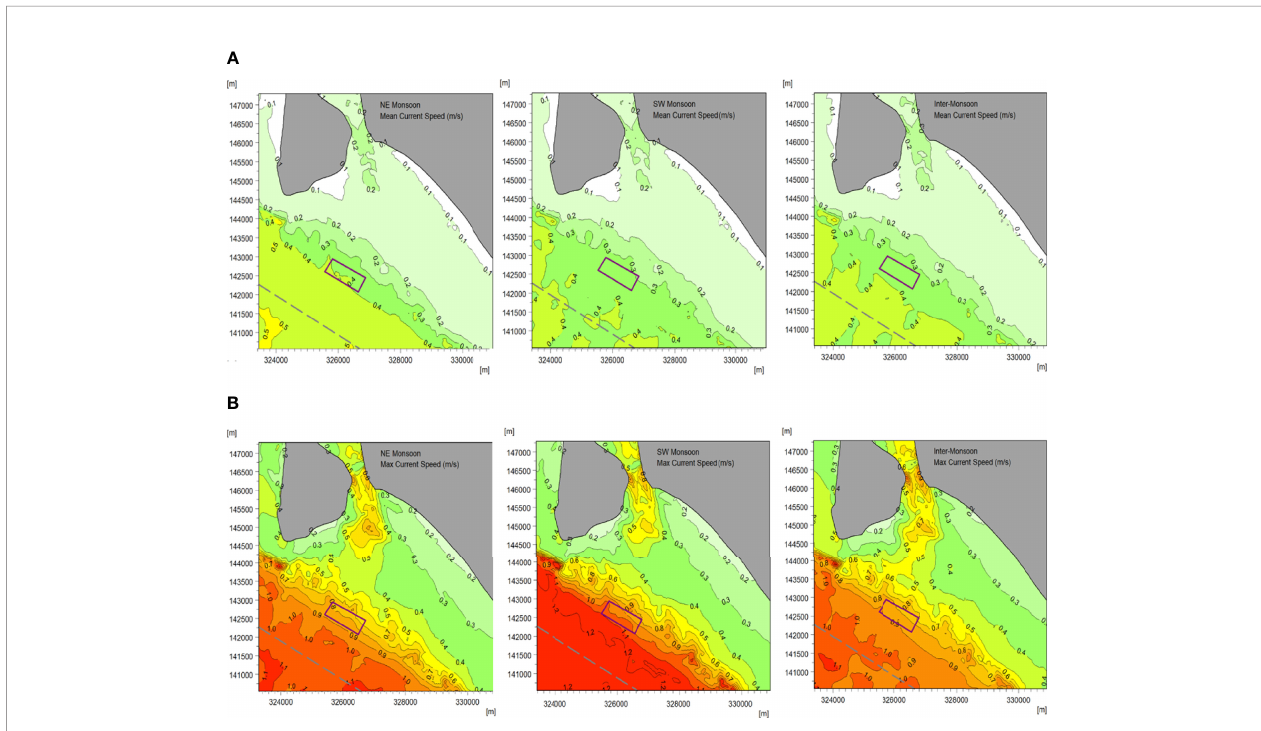
FIGURE 4 | Mean (A) and maximum (B) current speeds calculated from 28-day simulation results of a typical NE monsoon (left), SW monsoon (middle), and inter- monsoon